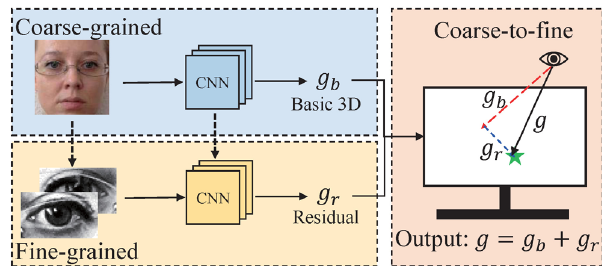
Fig. 11 Coarse-to-fine gaze prediction. Coarse-grained features are extracted from face images to estimate basic gaze direction g b while fine-grained features are extracted from eye images to estimate gaze residual g r . g r is used to refine g b to give the output gaze direction g . Reproduced with permission from Ref. [142], c (cid:2) Association for the Advancement of Artificial Intelligence 2020.